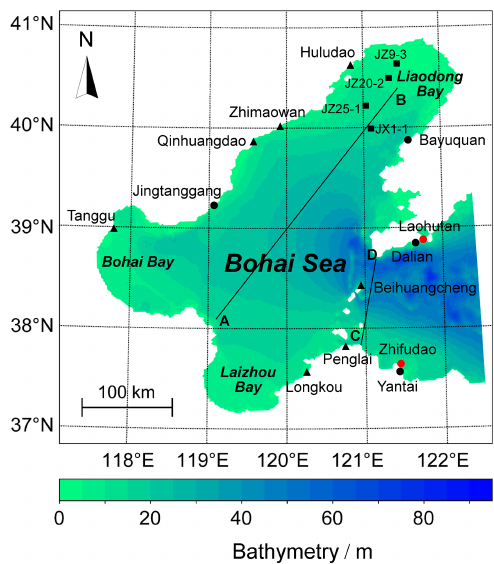
Figure 1. The location and bathymetry of the Bohai Sea. Black dots denote the coastal tide gauge stations. Red dots and black triangles indicate station locations with sea surface temperature and sea sur- face salinity observations, respectively. Black squares denote the oil platforms where the sea ice thickness observations were conducted. Line A–B represents the profile section along which temperature and salinity were presented (Figs. 6 and 7, respectively), while line C–D indicates the Bohai Strait. The straight line in the east denotes an open boundary for the regional ocean